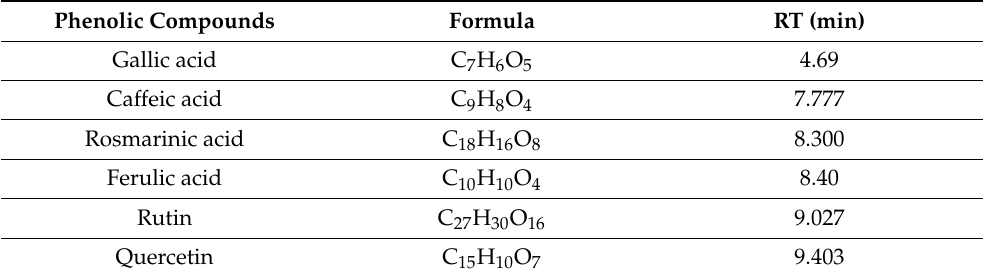
Figure 2. HPLC-DAD chromatogram of D. viscosa hydro-ethanolic extract. (1) Caffeic acid, (2) Rosmarinic acid, (3) Rutin, (4) Quercetin. Table 1. Phenolic compounds identified in D. viscosa and M. vulgare with their retention time